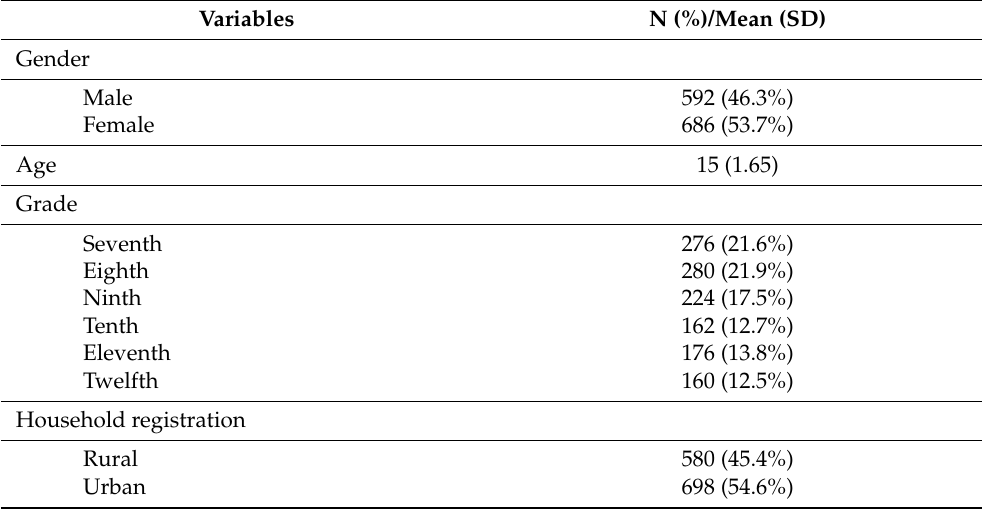
Table 1. Characteristics of the